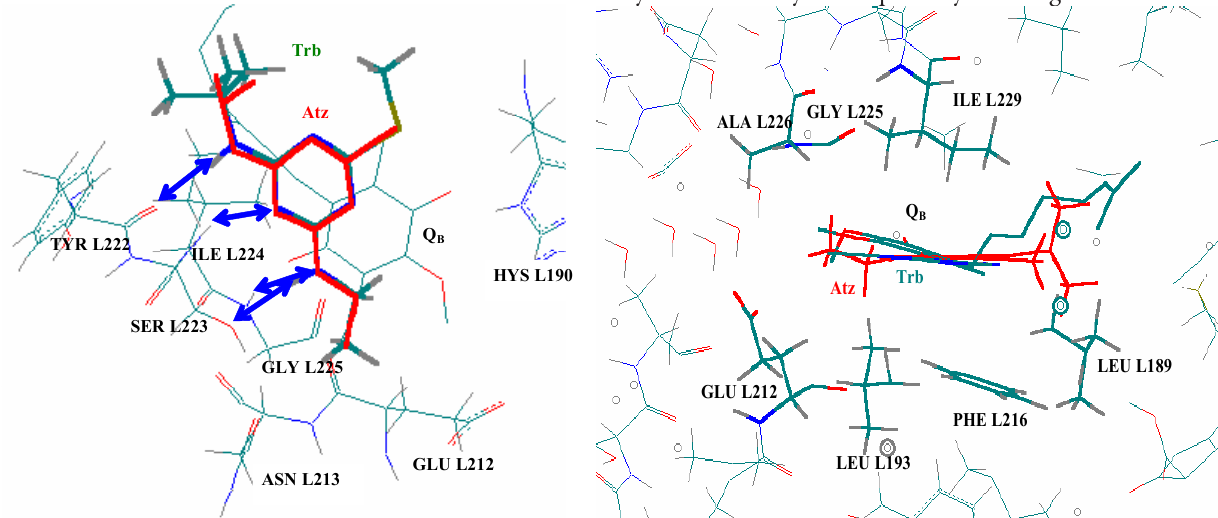
Fig. 5. The binding of atrazine (thick red line) and terbutryne (thick green line) to the reaction centre of Blastochloris (formerly Rho- dopseudomonas ) viridis according to the crystal structure. Figure was completed by using the files downloaded from the Brookhaven Protein Data Bank: 2prc (RC/ubiquinone), 1dxr (RC/terbutryne), 5prc (RC/atrazine) complexes. The arrows show the possible hydrogen bonds (the distances shorter than 3 Å) and neighbouring amino acid groups. Graph was completed by HyperChem